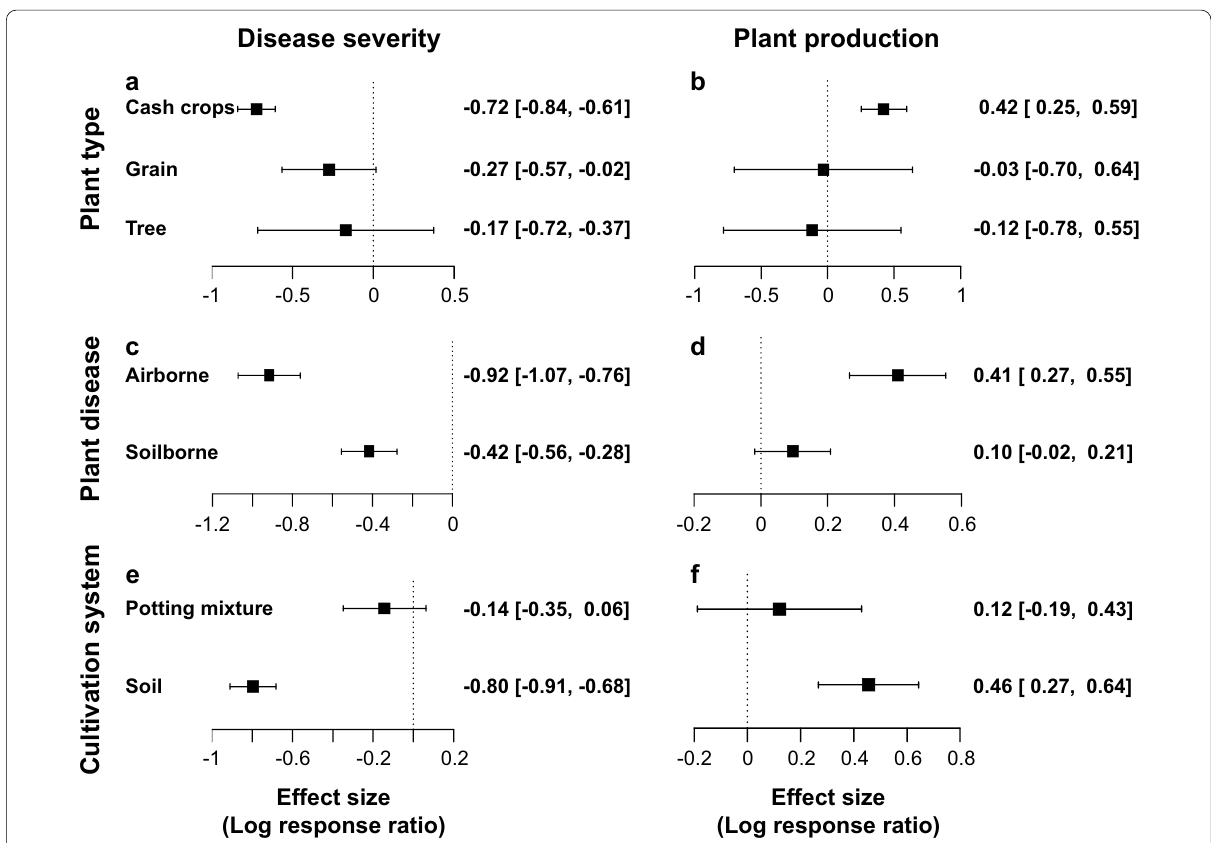
Fig. 3 Influence of plant type ( a , b ), plant pathogen ( c , d ), cultivation system ( e , f ) on plant disease suppression and plant growth,